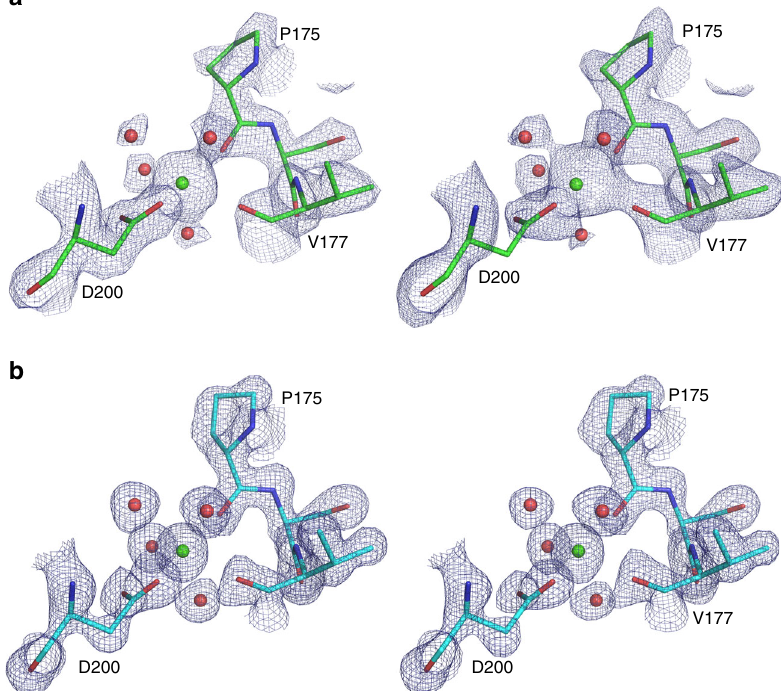
Fig. 3 Comparison of electron density maps from proteinase K structures obtained from different diffraction methods showing the calcium binding site with the coordinating water molecules. a Structure obtained from our single shot pink-beam serial crystallography experiment. b Proteinase K structure from conventional single crystal rotation photographs (PDB ID: 2PRK). The blue grid represents 2mF o − DF c maps (left side) and 2mF o − DF c simulated annealing composite omit maps (right side) both at a contour level of 1.5 σ , respectively